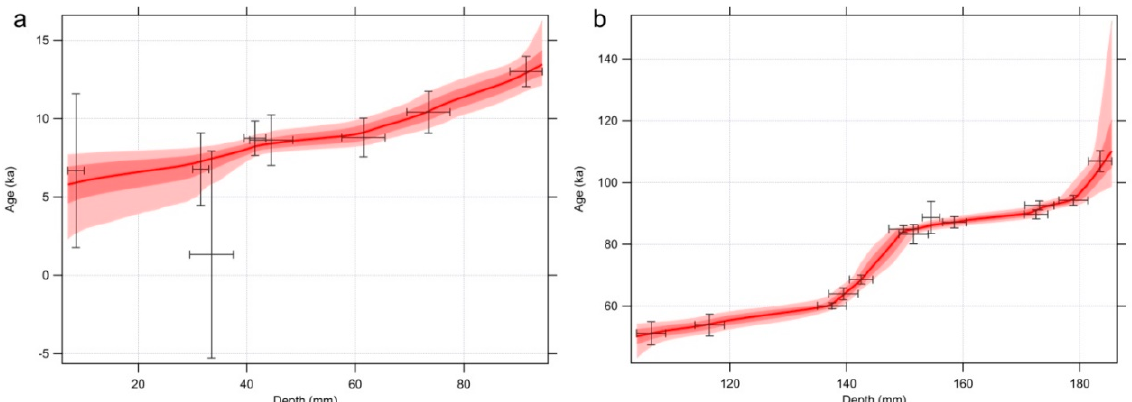
Figure 3. ( a ) Age–depth model for the younger part of MP-2 (from subsample 86 in Figure 2a above); ( b ) composite age–depth model for the older part of the MP-2 (under the subsample 86 in Figure 2a) and MP-3 (from the bottom up to subsample 1 in Figure 2b) stalagmites. Dark red and light red shaded areas represent the 68% and 95% confidence intervals, respectively.